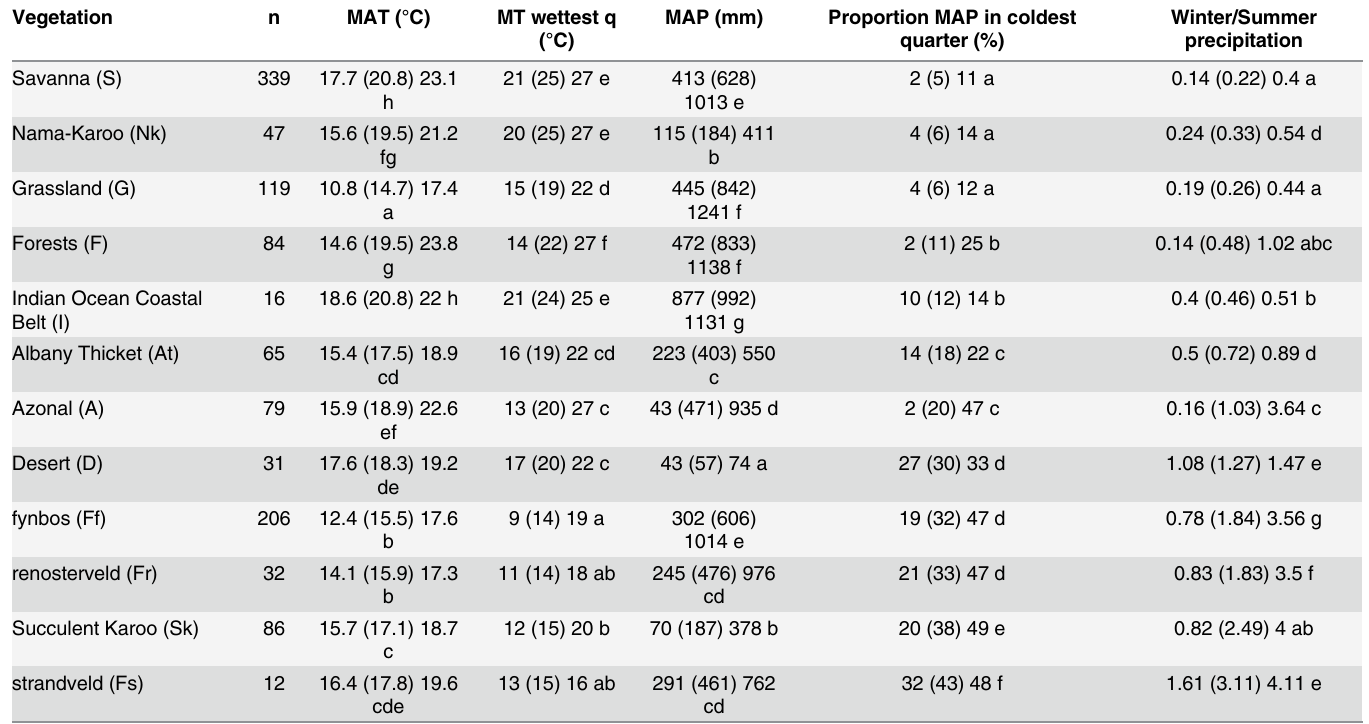
Table 1. Climate characteristics associated with vegetation types of South